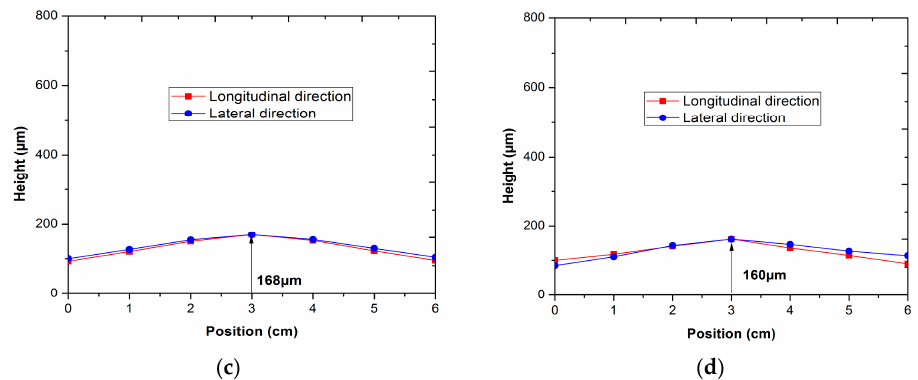
Figure 5. The effect of applied loads on the flatness of the anode ‐ supported electrolyte: ( a ) 0 g ∙ cm − 2 ;